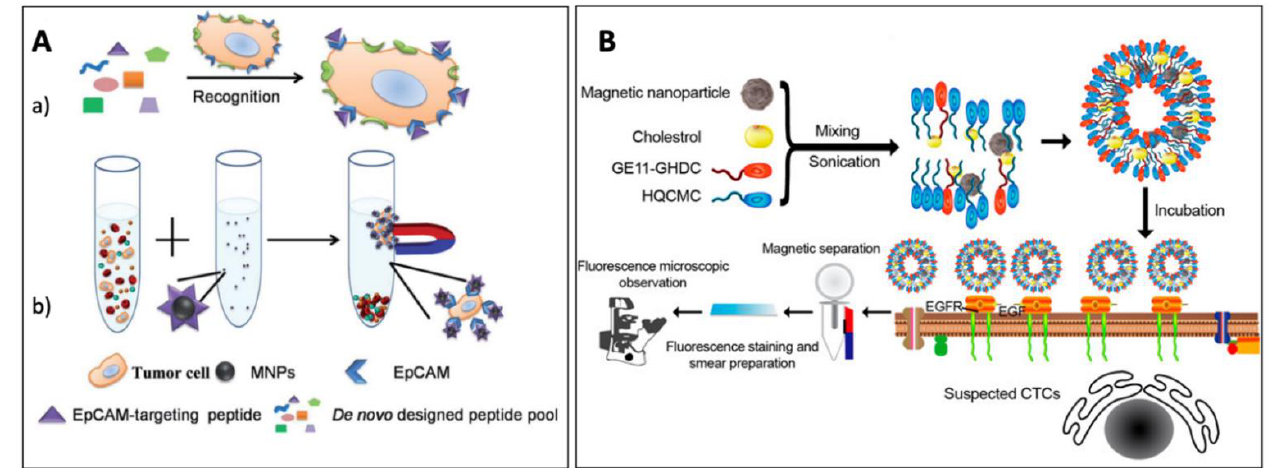
Figure 6. Peptide-based cell isolation. ( A ) Schematic illustration for ( a ) peptide screening and ( b ) tumor cell isolation using peptide modified magnetic particles. Republished with permission of the Royal Society of Chemistry from [121]; permission conveyed through Copyright Clearance Center, Inc. ( B ) Construction of peptide magnetic nanovesicles with high affinity for EGFR-expressing cancer cells for enhanced capture of CTCs. Adapted with permission from [122] Copyright © 2016 American Chemical